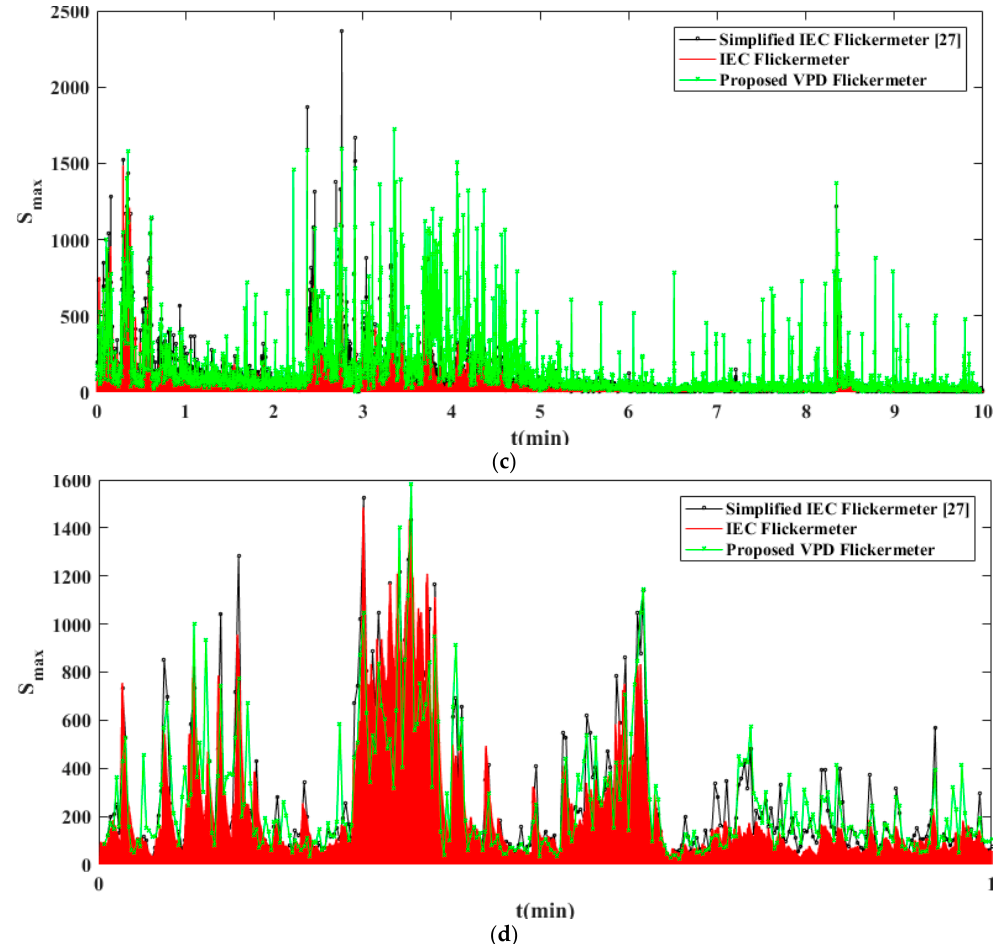
Figure 5. Evaluations for phase 3 ( a ) RMS variation; ( b ) fundamental frequency variation; ( c ) comparison of 10 min S max for different methods; ( d ) comparison of 1 min zoomed version of (cid:1845) (cid:3040)(cid:3028)(cid:3051) for different methods.